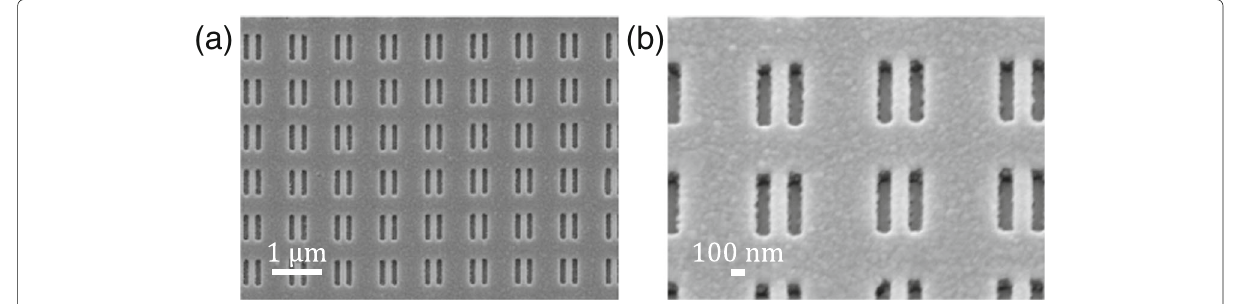
Fig. 3 The SEM image of a the metasurface polarizer and b its magnified image